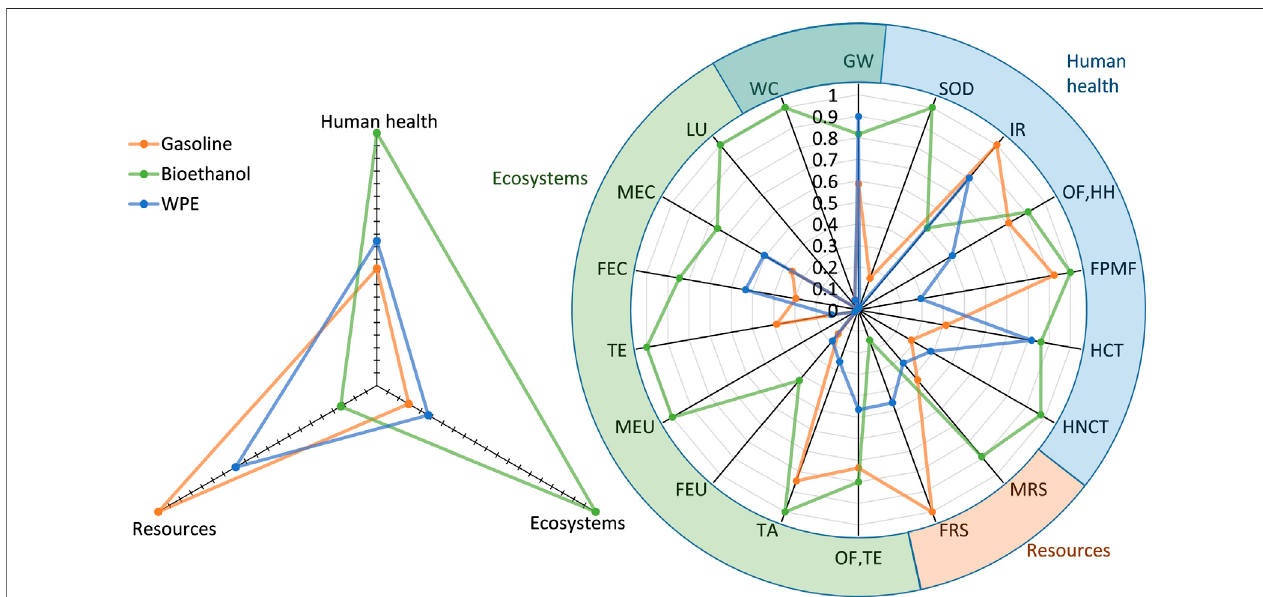
FIGURE 8 | Normalized LCA endpoint and midpoint indicators comparison for gasoline, bioethanol and WPE production pathways. GW: global warming; SOD: stratosphericozone depletion; IR:ionizingradiation;OF,HH: ozoneformation,humanhealth;FPMF: fi neparticulate matterformation; OF,TE:ozone formation, terrestrial ecosystems; TA: terrestrial acidi fi cation; FEU: freshwater eutrophication; MEU: marine eutrophication; TE: terrestrial ecotoxicity; FEC: freshwater ecotoxicity; MEC: marine ecotoxicity;HCT:humancarcinogenictoxicity;HNCT: humannon-carcinogenictoxicity; LU:landuse;MRS:mineralresourcescarcity;FRS: fossilresource scarcity; WC: water consumption. WPE: plastic waste pyrolysis-sourced ethanol. Endpoint and midpoint values are available in Supplementary Table S3